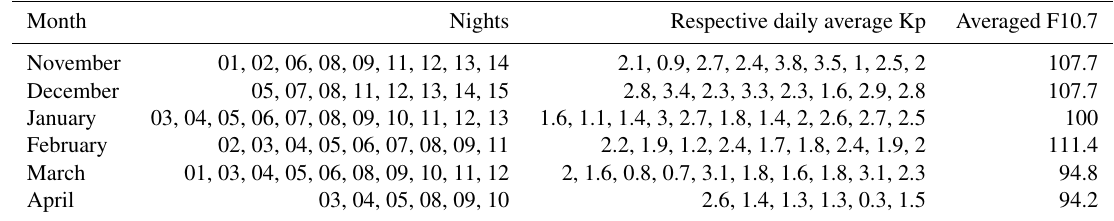
Table 1. Number of nights averaged in each month and the corresponding averaged solar flux and geomagnetic indices.